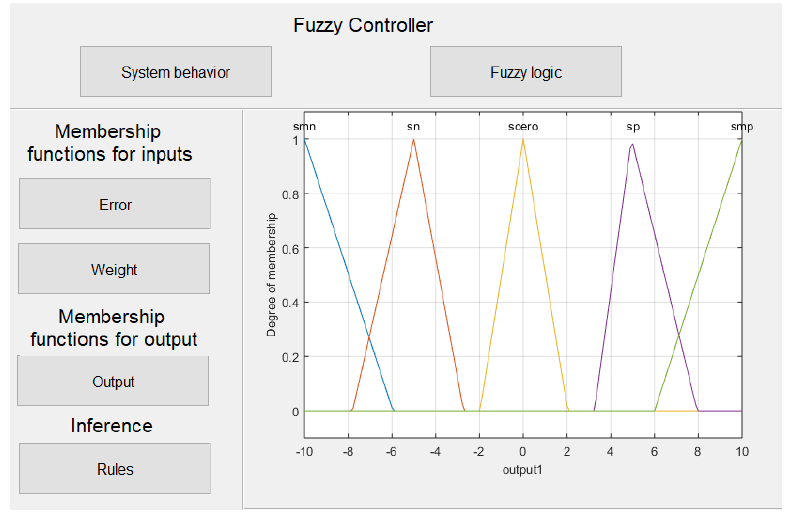
Figure 5. GUI screen for fuzzy logic.